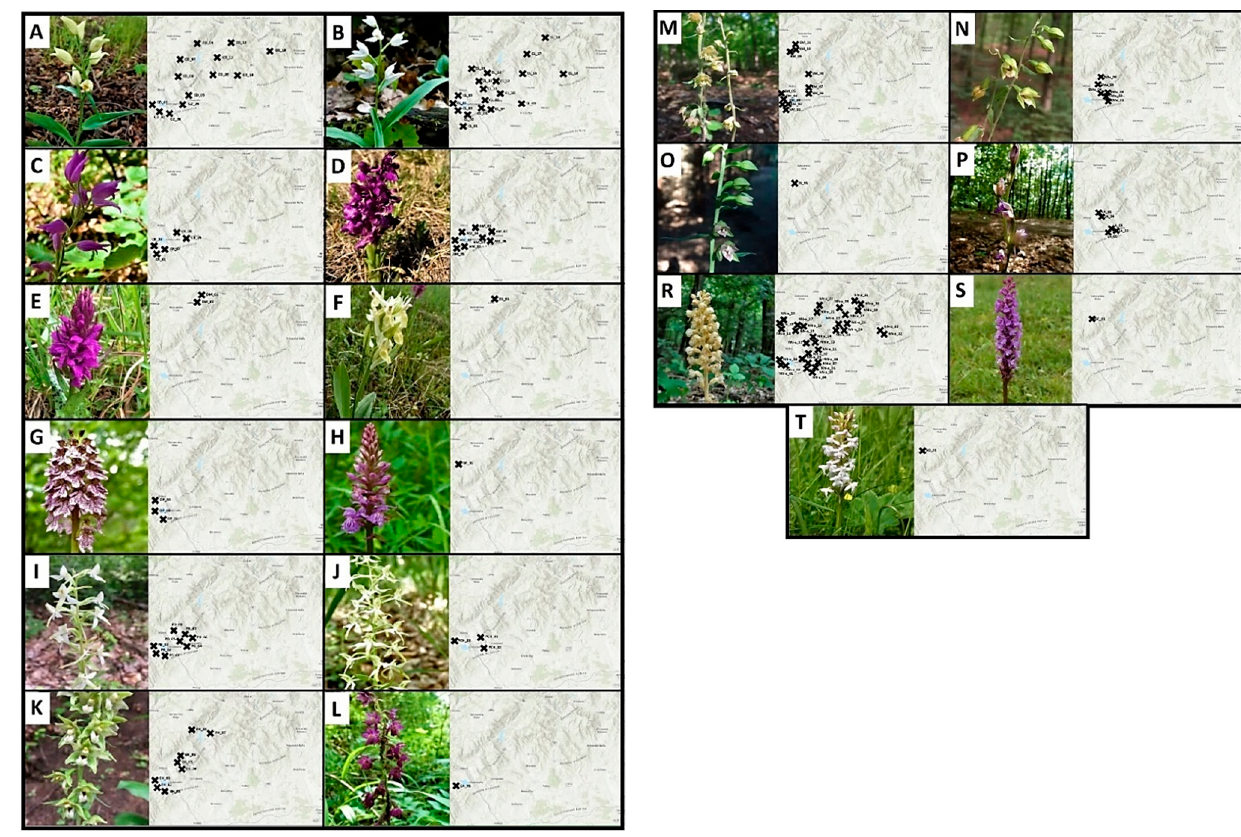
Figure 4. Distribution of orchids in the Western Carpathians: ( A ) Cephalanthera damosonium, ( B ) Cephalanthera longifolia, ( C ) Cephalanthera rubra, ( D ) Anacamptis morio, ( E ) Dactylorhiza majalis, ( F ) Dactylorhiza sambucina, ( G ) Orchis purpurea, ( H ) Dactylorhiza fuchsii, ( I ) Platanthera bifolia, ( J ) Platanthera chlorantha, ( K ) Epipactis helleborine, ( L ) Epipactis atrorubens, ( M ) Epipactis microphylla, ( N ) Epipactis muelleri, ( O ) Epipactis leptochila, ( P ) Limodorum abortivum, ( R ) Neottia nidus-avis, ( S ) Gymnadenia conopsea, ( T ) Gymnadenia